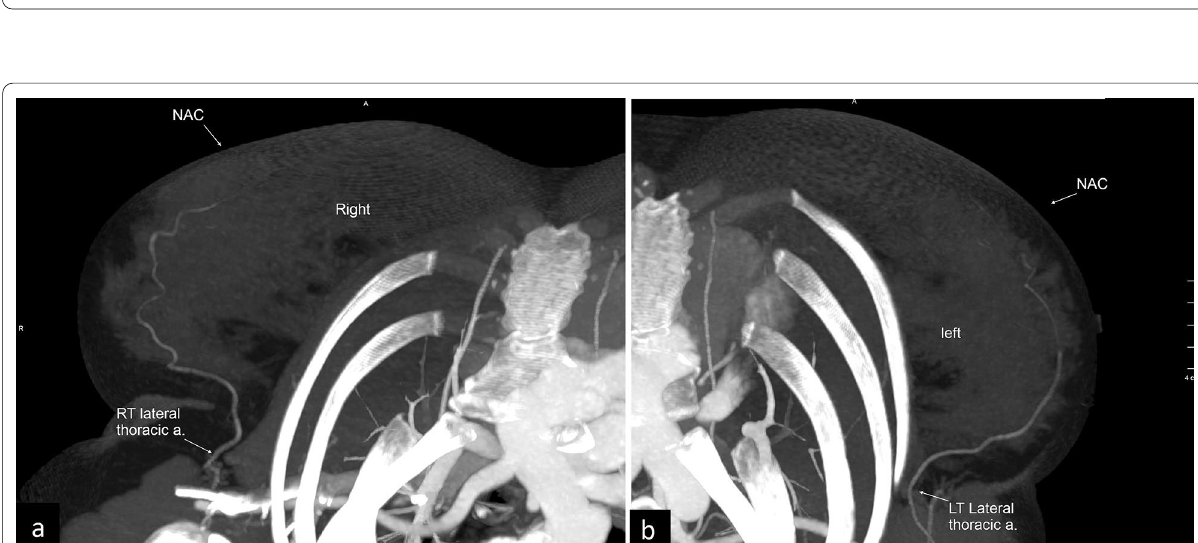
Fig. 4 Effect of dense breast parenchyma on MIP image. Axial MIP images of right ( a ) and left ( b ) breasts in a 22-year old female patient with dense glandular parenchyma. She has dominant lateral thoracic artery supply to NAC. However, the terminal end of the arterial supply could not be traced well due to dense glandular parenchyma which is an issue in young